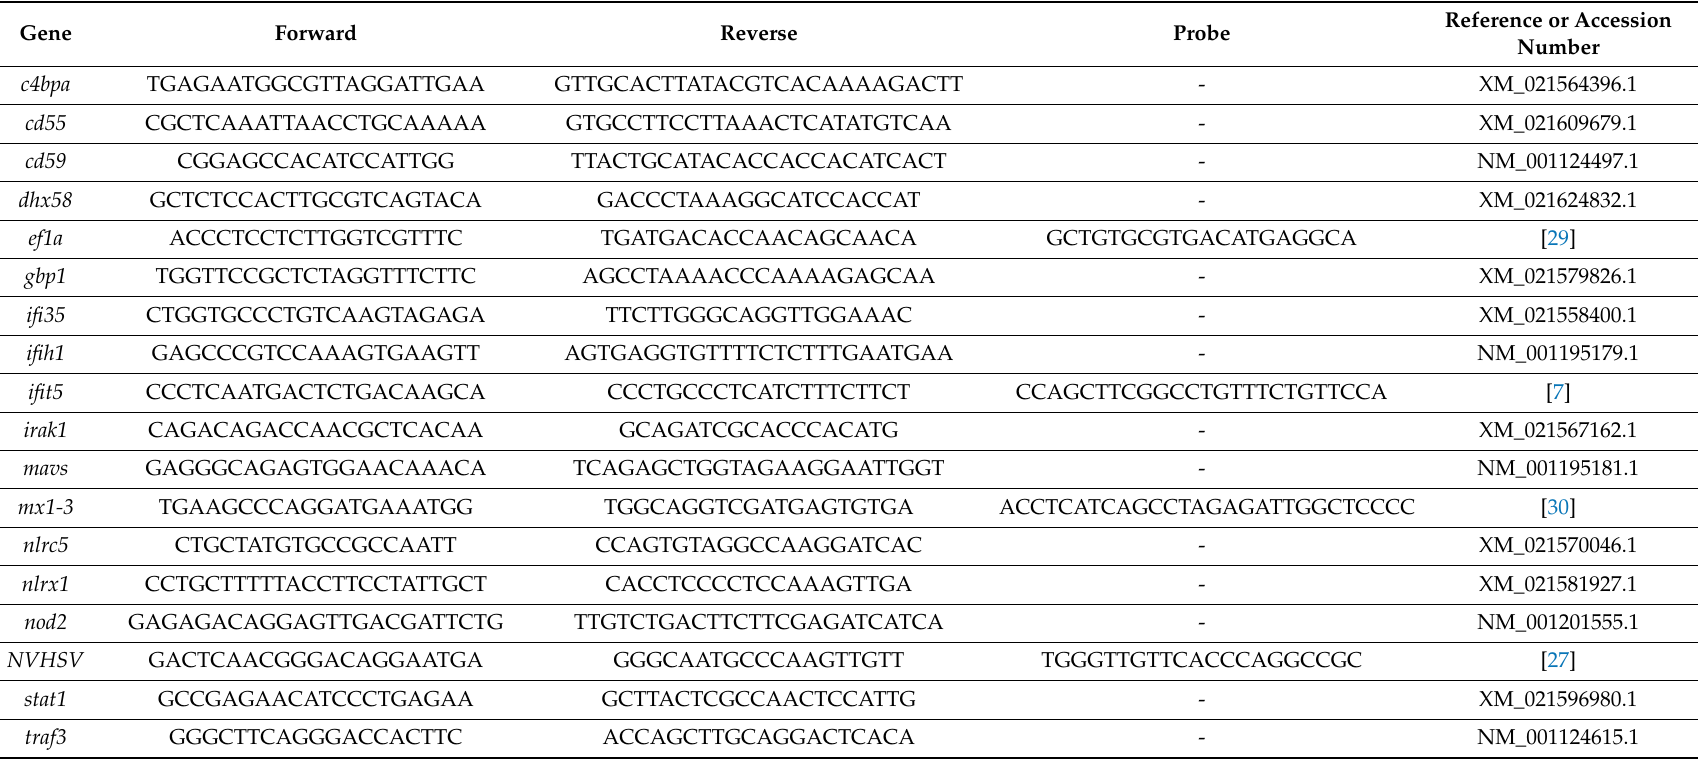
Table 1. Primer sequences used in quantitative